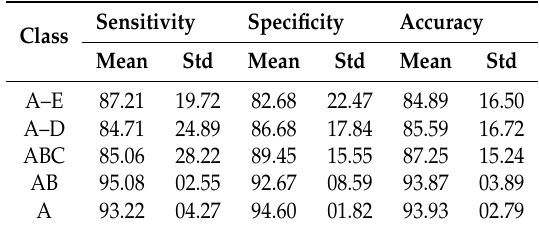
Table 4. Statistical performance (%) of means of sensitivity, specificity and accuracy in different feature